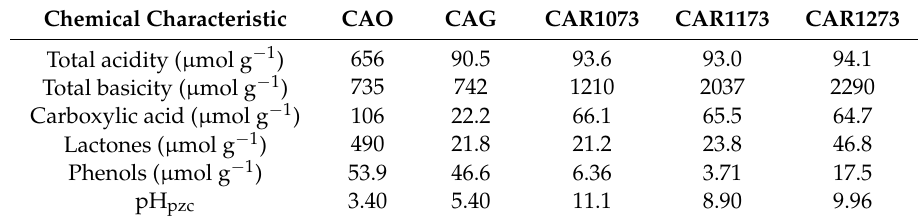
Table 5. Chemical characteristics of the activated carbons CAO, CAG, CAR1073, CAR1173, and CAR1273.